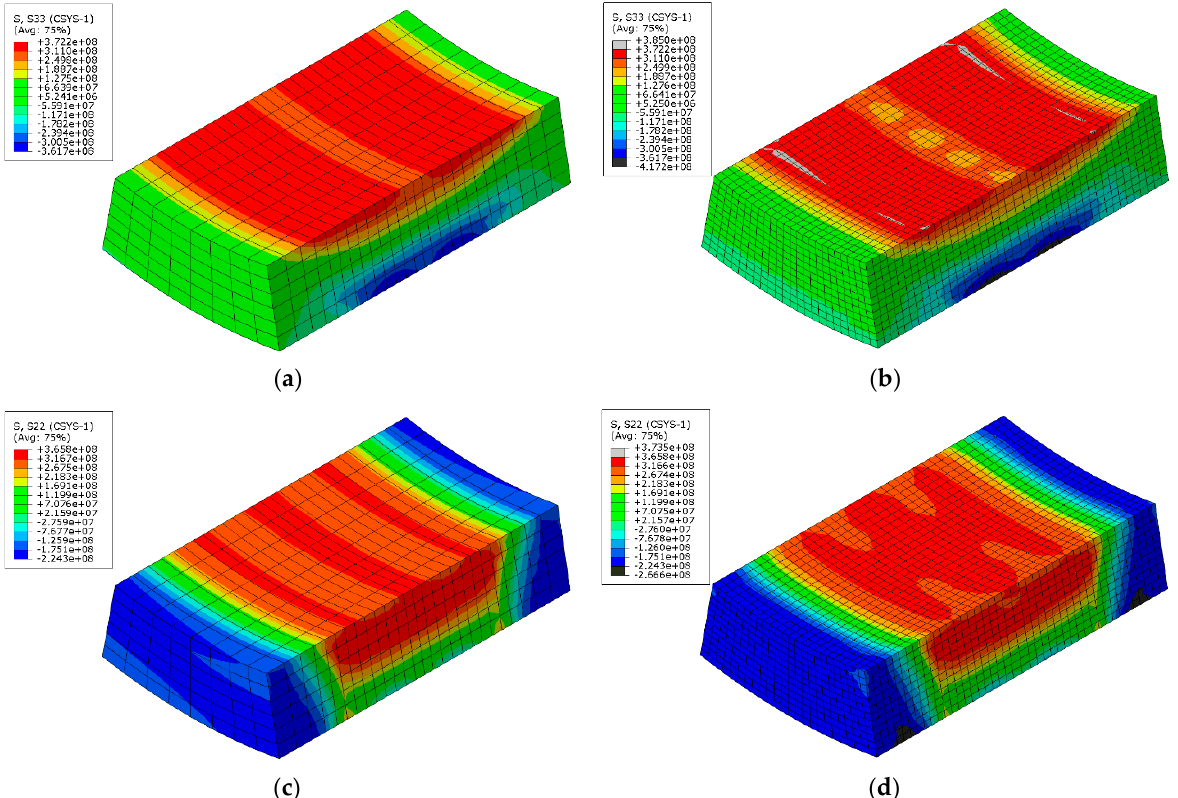
Figure 7. Residual stress profiles of global model and submodel along line z 1- z 2, α = 90°, (Figure 2), ( a ) axial stress, ( b ) hoop stress.